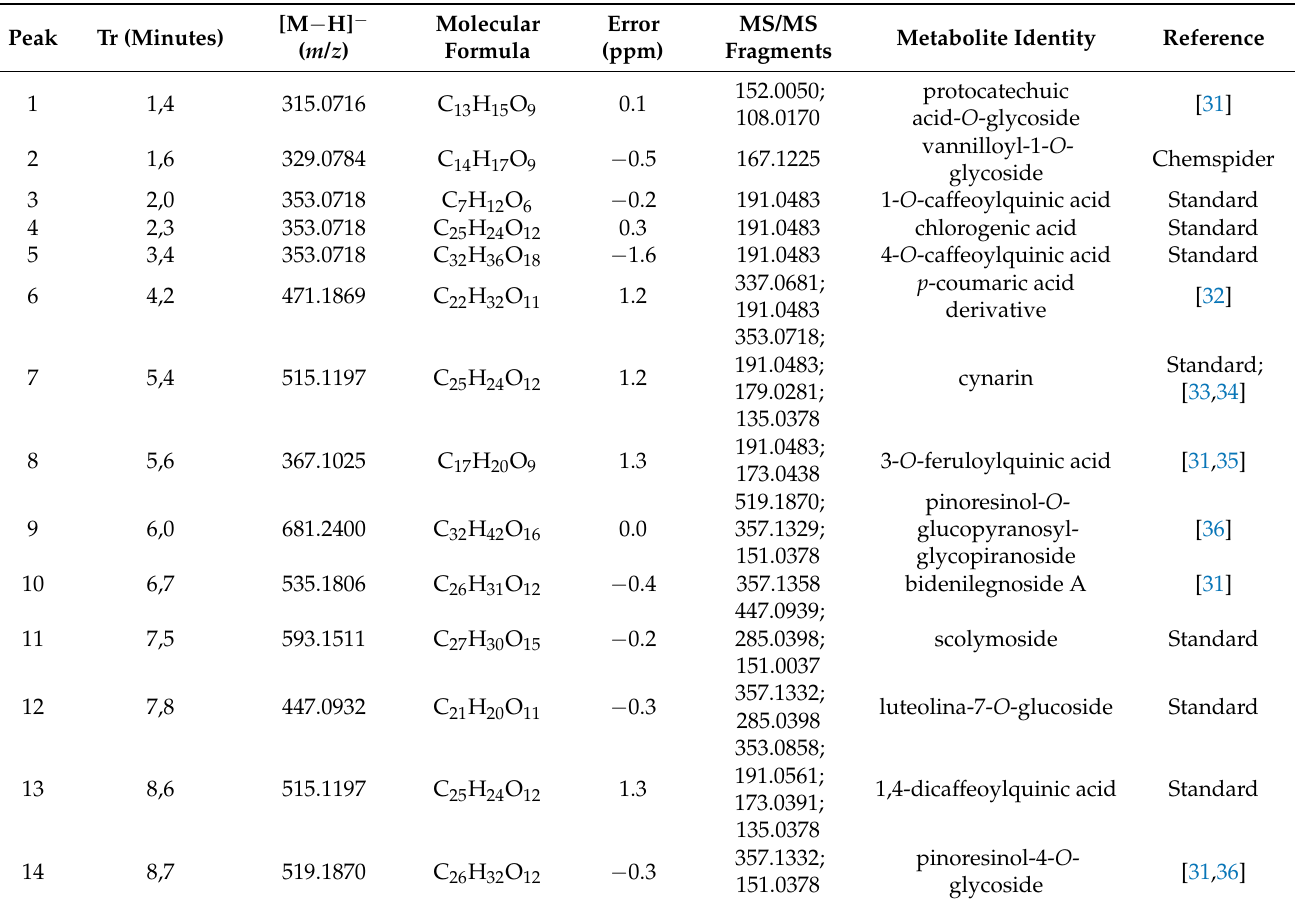
Table 2. Metabolites identified in the green extract of C. cardunculus leaves.